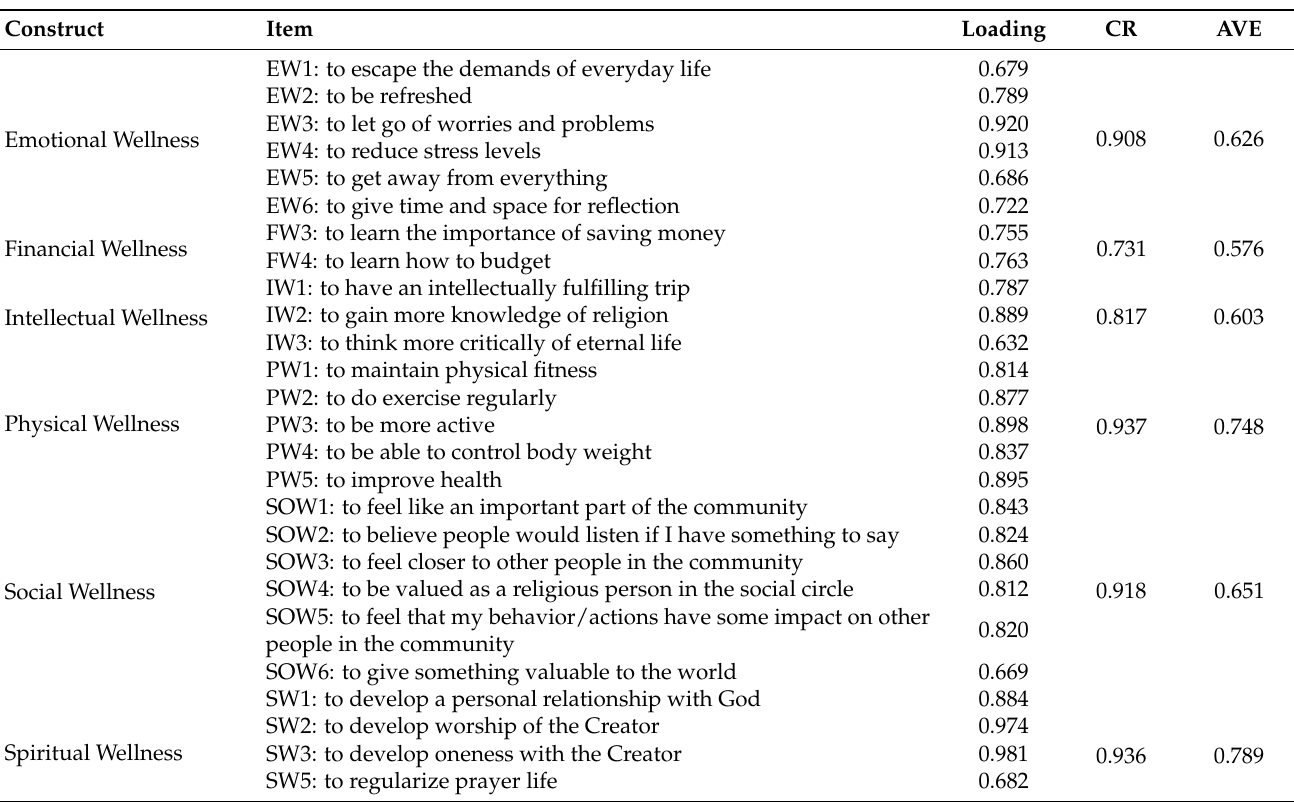
Table 1. Item Descriptions and Measurement